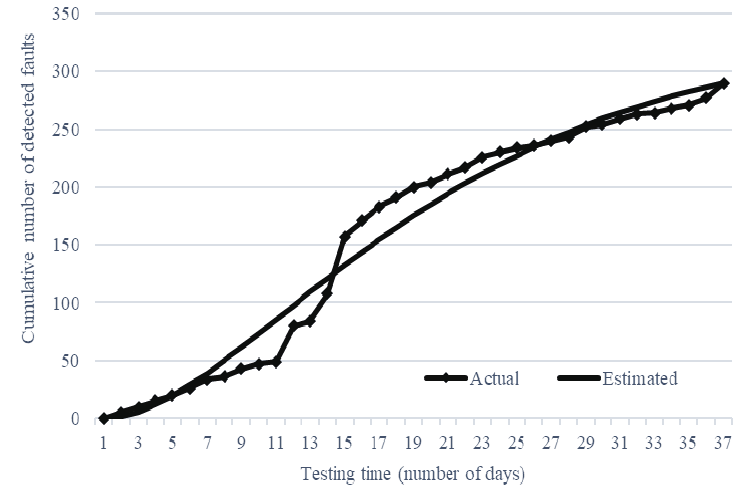
Figure 2. Estimated delayed S-shaped